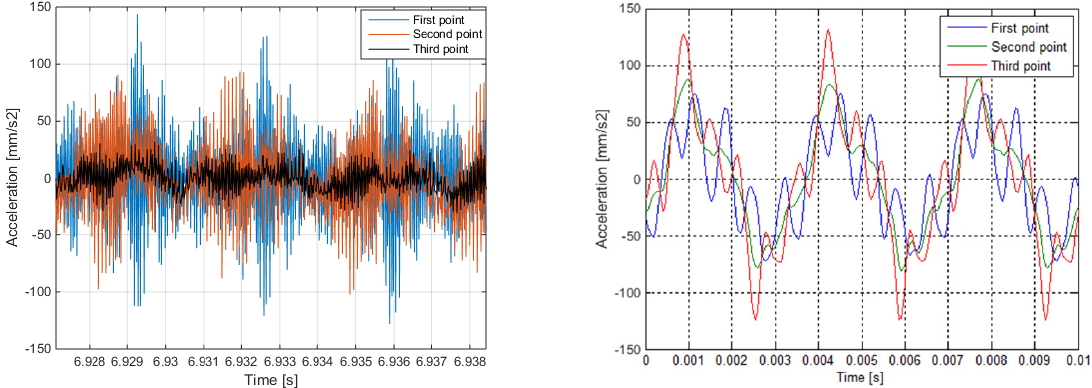
Figure 26. Comparison of measured ( left ) and calculated ( right ) vibration signal. One can see that the vibration signal along axial length of the stator changes both in measurements and in simulation. The amplitude of the signal is greater on one end of the stator. The vibration signal waveforms are different, however. In case of simulation, the machine was supplied from sinusoidal current source, but during measurements the machine was supplied from an inverter with PWM. The amplitudes and harmonics present in the vibration signal are different in measured and simulated signals. However, it was possible to predict the behavior of the structure by running NVH